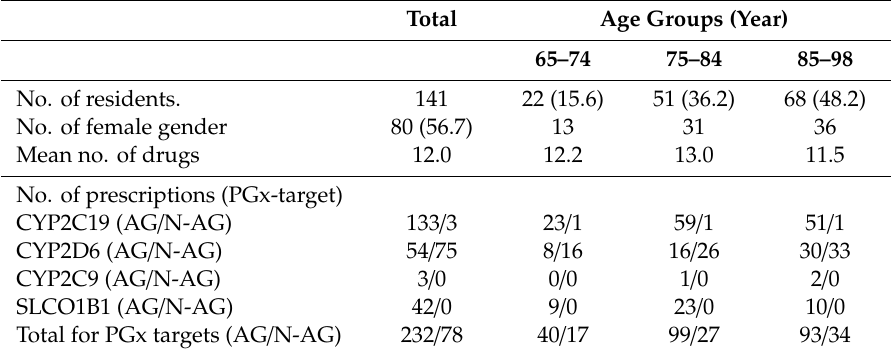
Table 1. Demographic characteristics, drug use and number of prescriptions for pharmacogenomics (PGx) targets.